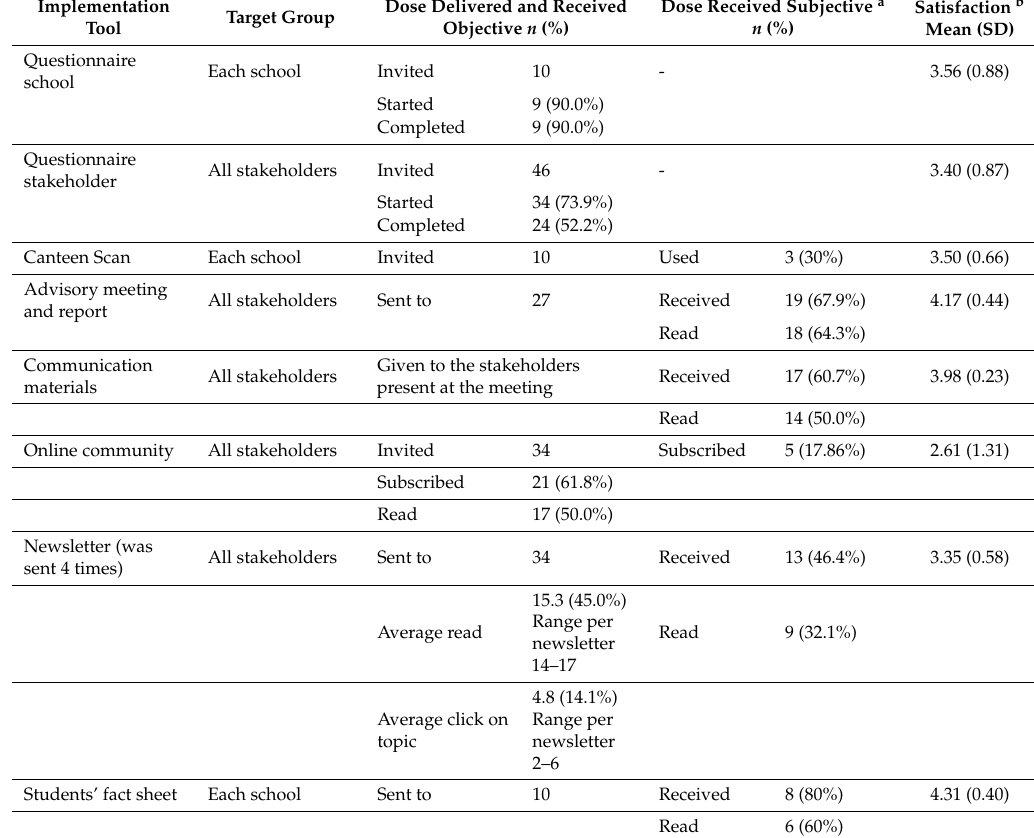
Table 4. Quality of implementation per implementation